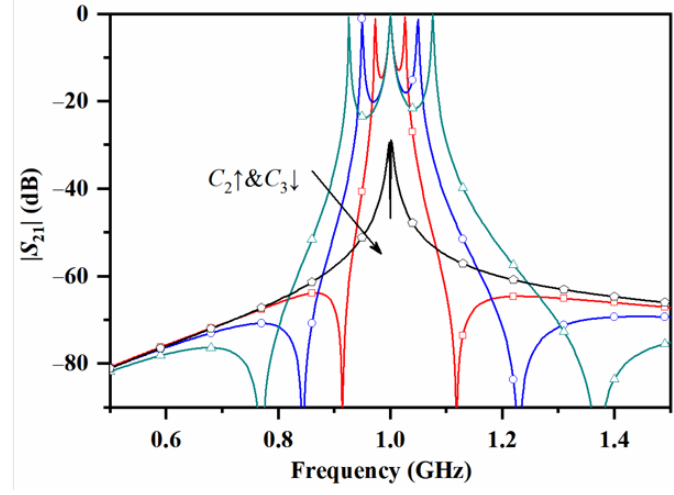
Figure 8. Transmission responses using weak coupling.